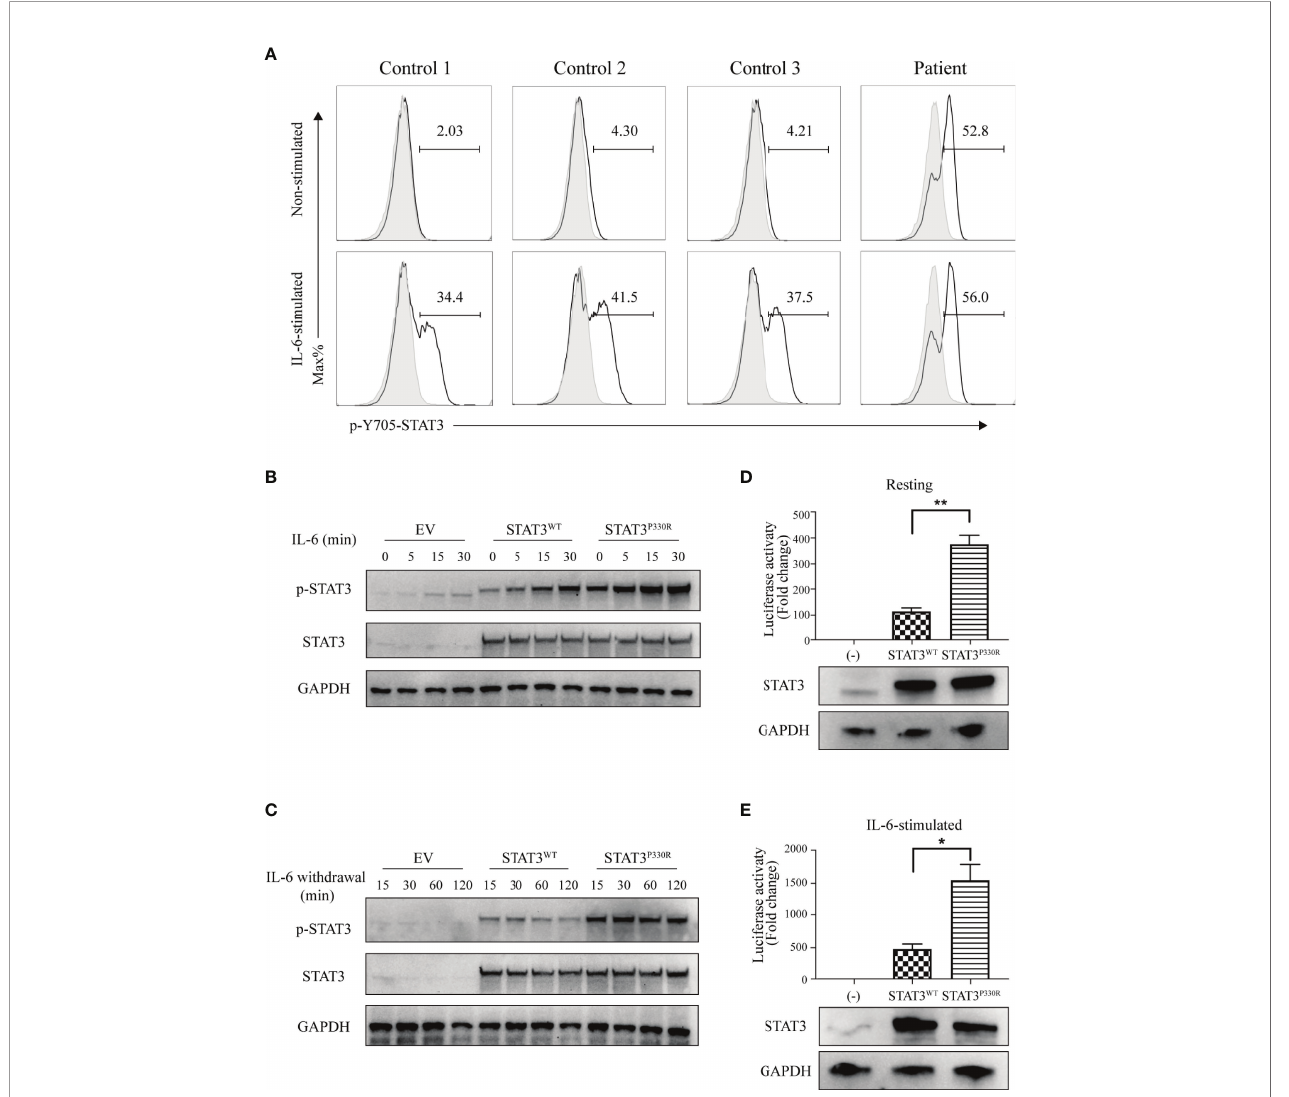
FIGURE 3 | The mutation leads to increased phosphorylation and transcriptional activity. (A) Flow cytometric analysis of phosphorylated STAT3 in PBMCs from the patient and healthy controls with or without IL-6 stimulation. (B, C) . Western blot shows the phosphorylation (B) and dephosphorylation (C) of STAT3 in the human embryonic kidney 293 (HEK293) cells transfected with STAT3 constructs. The total STAT3 and GAPPDH were used as the loading controls. EV, empty vector. The results are representative of three independent experiments, respectively. (D, E) The STAT3 relative luciferase activity in the absence (D) or presence (E) of IL-6 stimulation. The representative result from three independent experiments is shown, respectively. Relative STAT3 protein expression level was con fi rmed by western blotting. Data are mean ±SEM (n=3). * p < 0.05. ** p <